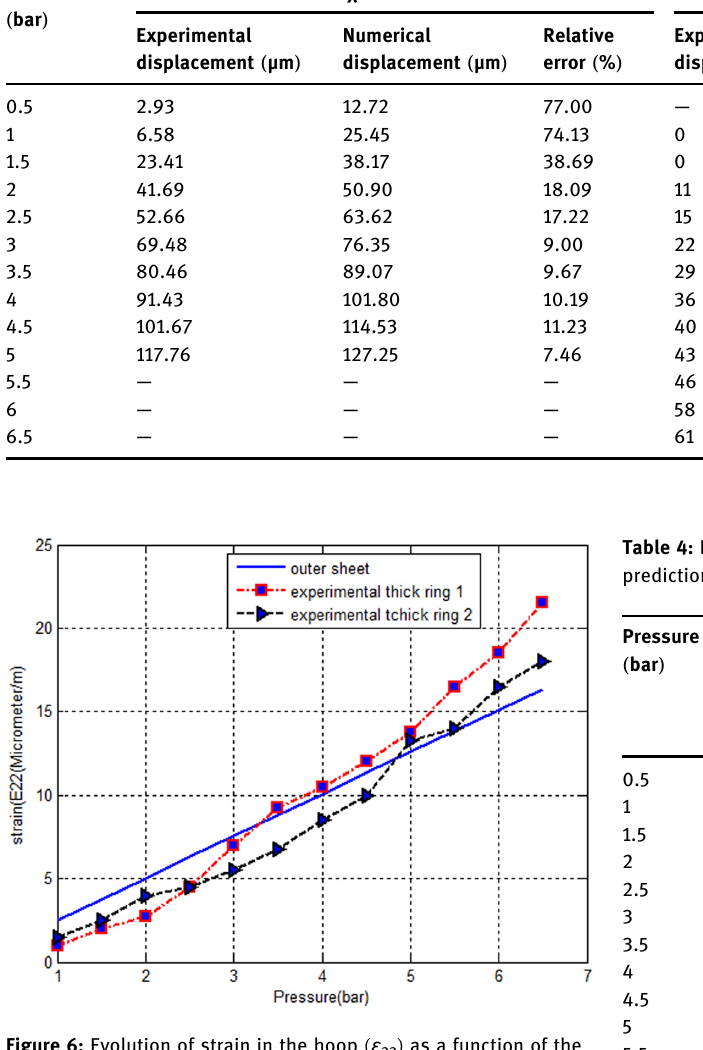
Figure 6: Evolution of strain in the hoop ( ε 22 ) as a function of the load ( χ = 0.1667 ) .